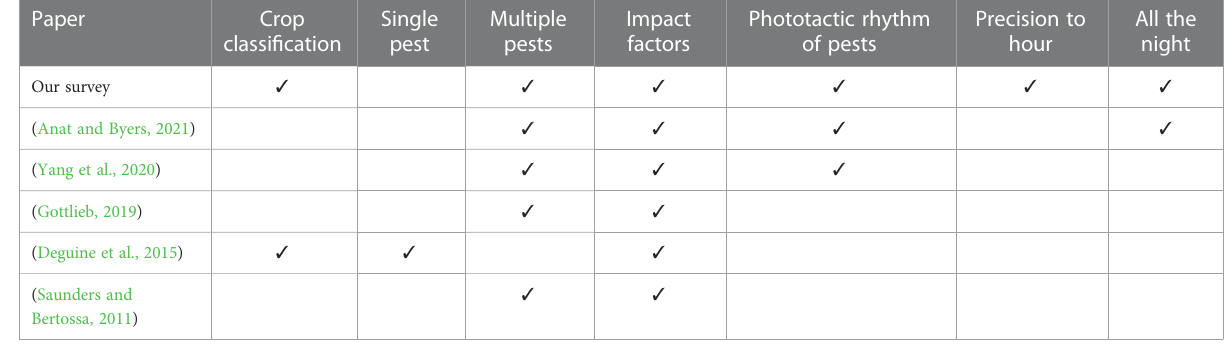
TABLE 1 Investigation and comparison of the phototactic rhythm of pests.